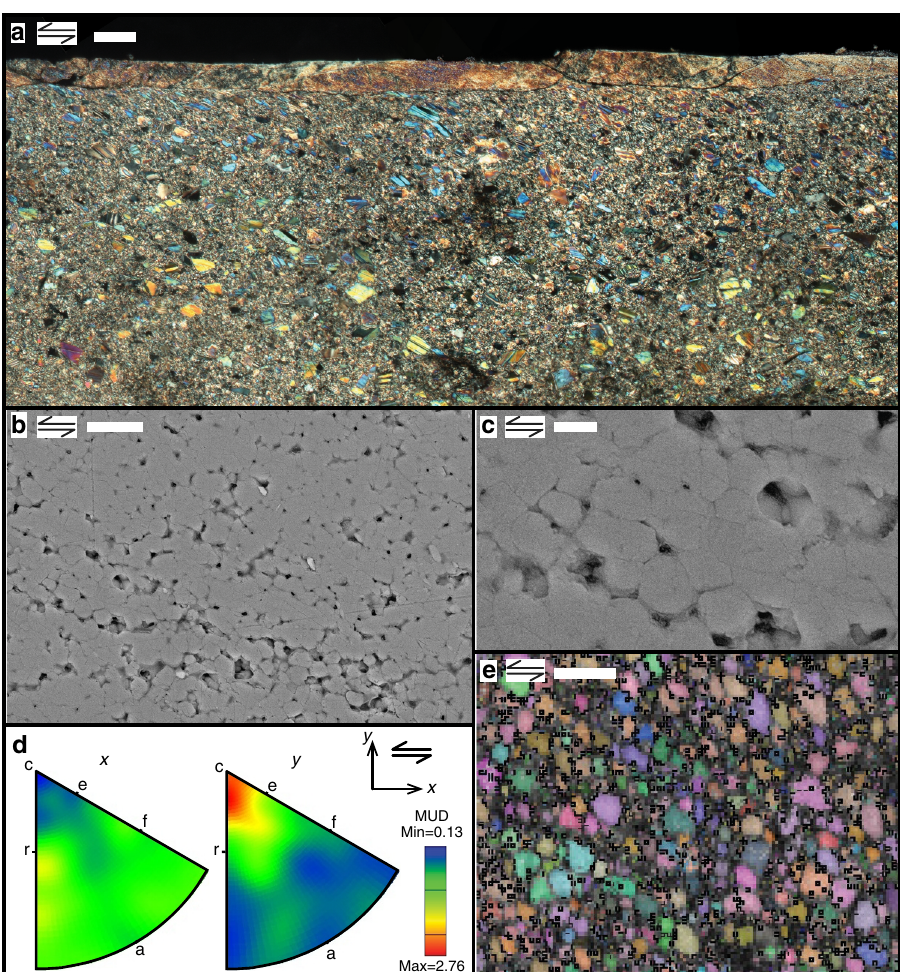
Fig. 3 Microstructure of simulated calcite fault gouge sheared at 550 °C at 100 μ m s − 1 . Double arrows indicate sense of shear. a Cross-polarized light micrograph. Scale bar, 50 µ m. b , c Backscatter electron micrographs taken within the shear band. Scale bars, 2 µ m ( b ) and 500 nm ( c ). d , e Electron backscatter diffraction (EBSD) of shear band grains. Step size, 0.1 μ m. d Upper hemisphere, equal area inverse pole fi gures plotting all EBSD data (7179 data points) in the Euler angle map of shear band grains shown in e . In d , the calcite crystallographic orientations are plotted with respect to an orientation parallel ( x ) and normal ( y ) to the shear direction. Scale bar, 2 µ m. MUD = mean uniform